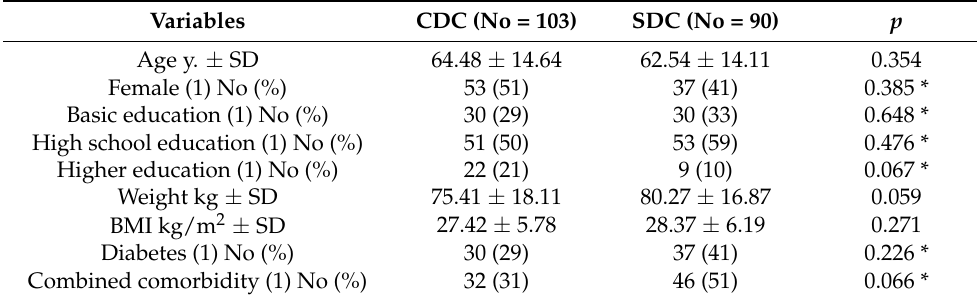
Table 1. Population characteristics in CDC and